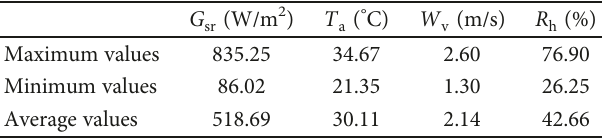
Figure 7: Yearly hourly average values of relative humidity. Table 5: Yearly average values of climatic conditions.